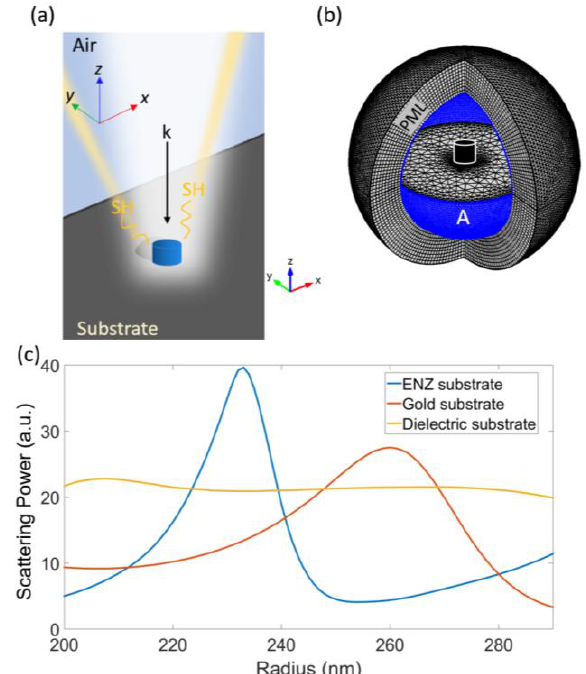
Figure 1. ( a ) Sketch of the proposed structure; ( b ) simulated model with the discretization mesh; ( c ) scattering power at varying cylinder radius ( h = 400 nm) for the different considered substrates, I 0 = 1.6 GW/cm 2 .